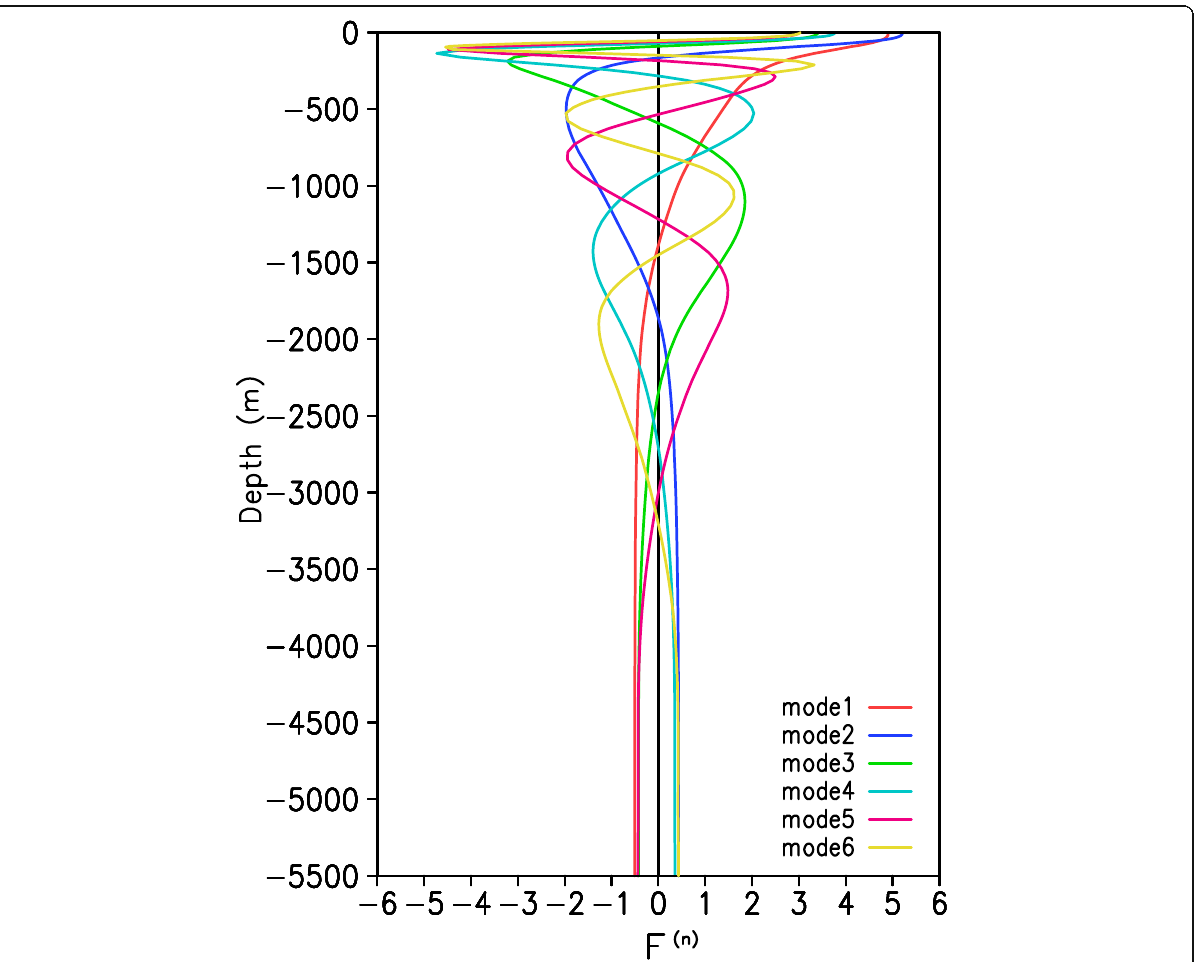
Fig. 9 The vertical profiles of eigenfunctions F ( n ) associated with fundamental six baroclinic modes in the tropical Indian Ocean, calculated by solving the Sturm-Liouville problem. Details are in the